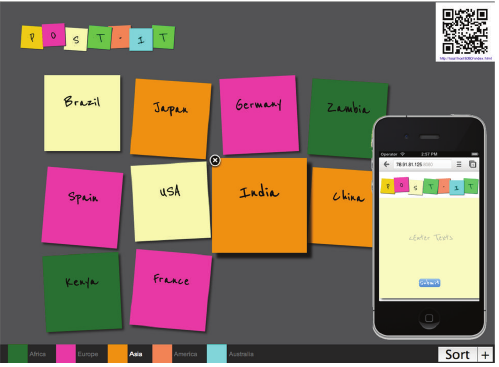
Figure 1: The Post-It application (student view shown to the right).